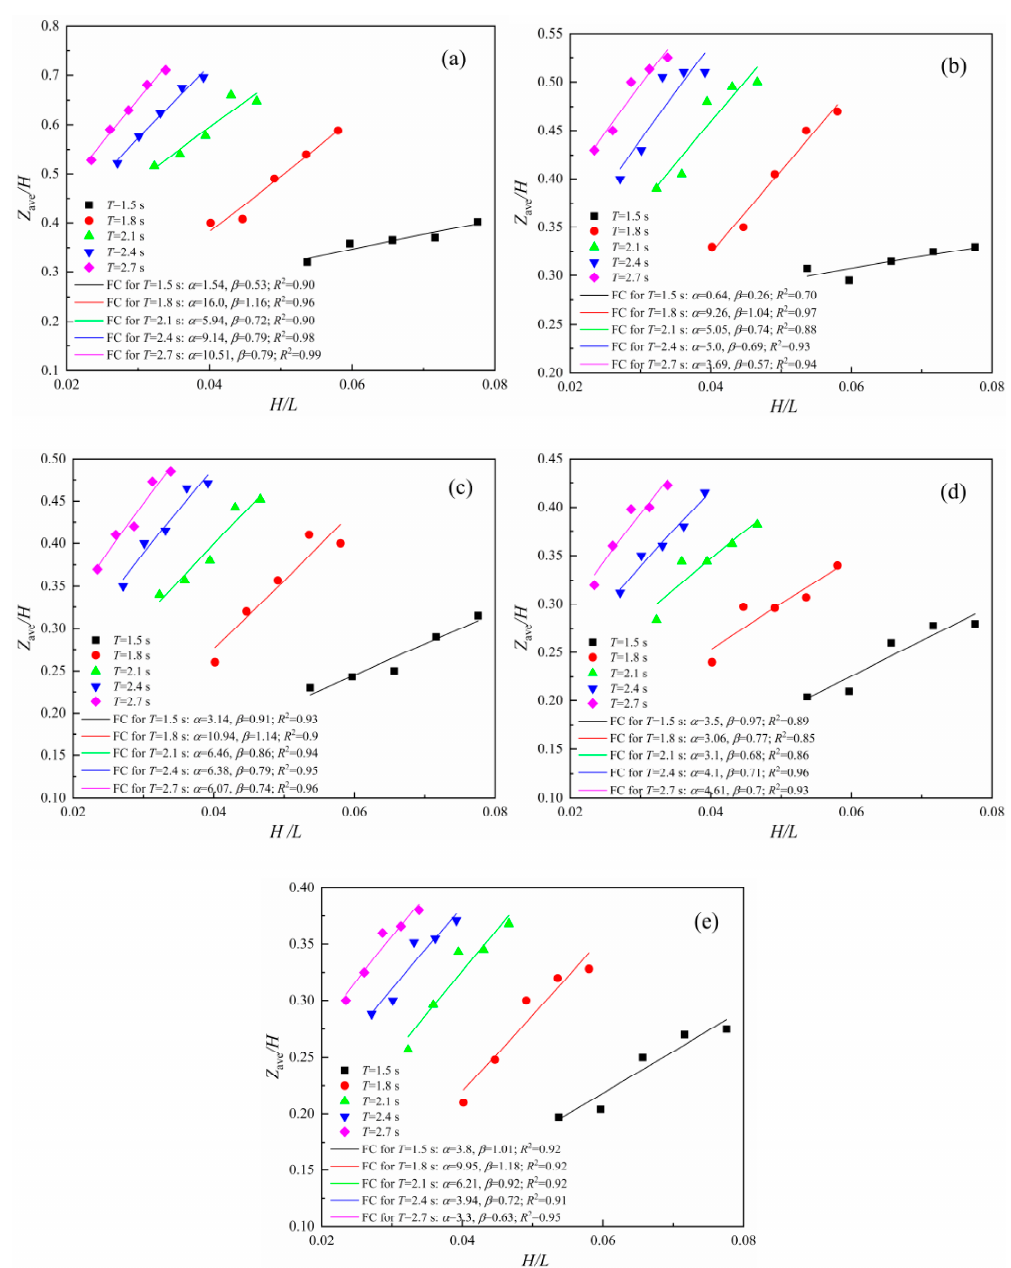
Figure 5. Z ave / H relationship with H / L. ( a ) h = 0.1 m; ( b ) h = 0.2 m; ( c ) h = 0.3 m; ( d ) h = 0.4 m; ( e ) h = 0.5 m.